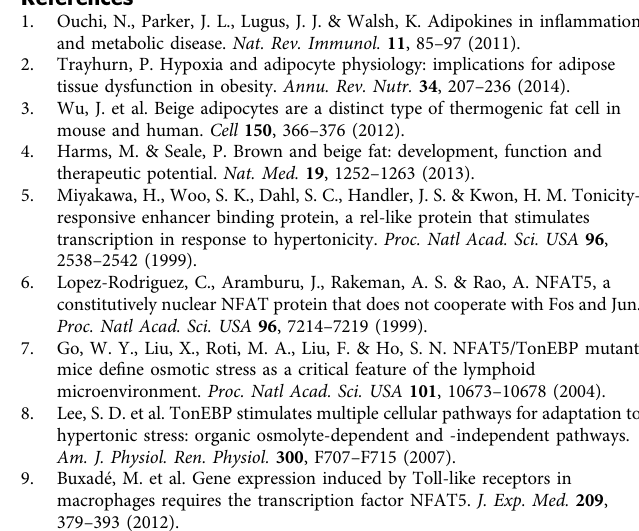
Fig. 6 Adipocyte-speci fi c TonEBP de fi ciency promotes energy expenditure and beiging of WAT. a Body weight, fasting blood glucose, and food intake by adipocyte-speci fi c TonEBP knockout mice ( TonEBP fl / fl , AQ-cre ) and their cre-negative littermates ( TonEBP fl / fl ) fed with HFD for 12 weeks ( n = 10). VO 2 ( b ), VCO 2 ( c ), heat production ( d ), and rectal temperature ( e ) analyzed in animals fed with HFD ( n = 4). mRNA expression of thermogenic genes in iWAT from animals fed with HFD ( f ) or exposed to cold conditions ( g ) ( n = 4). h Representative images of iWAT sections stained with H&E, UCP-1, and